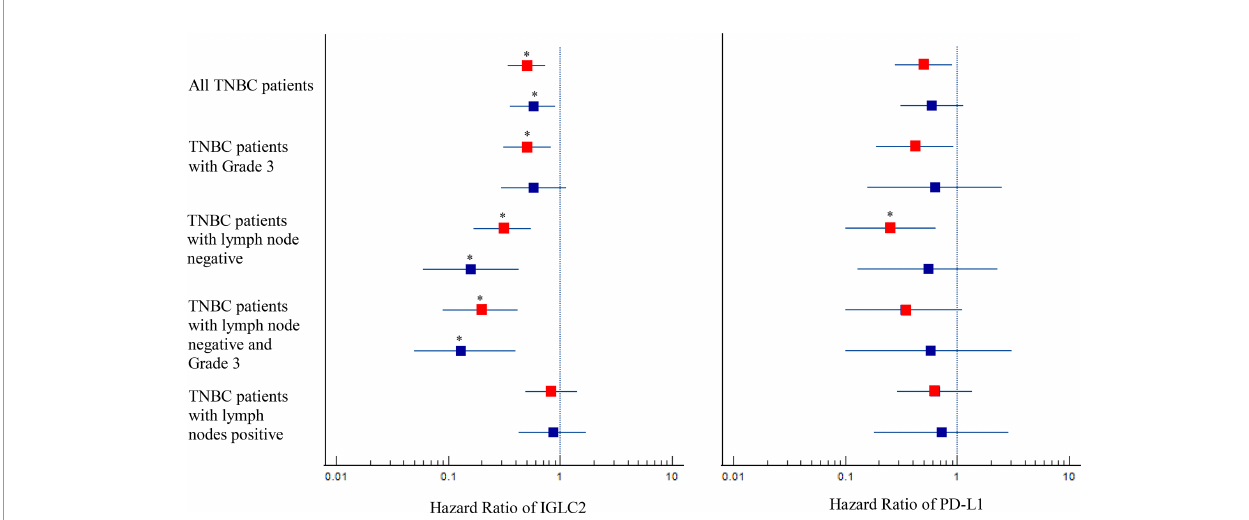
FIGURE 2 | Forest plot with hazard ratio (HR) for IGLC2 and PD-L1 of Kaplan – Meier (KM) survival analysis of RFS and DMFS. The HRs were obtained from the KM plotter online tool. The analysis data were grouped as a whole, by lymph node status, and by Grade 3. The boxplot was the 95% CI of HR. A 95% CI of HR not equal to 1 denotes statistical signi fi cance before multiple comparison adjustment. The HR results of RFS were marked in red, and those of DMFS were marked in blue. The correction of multiple comparisons was using Benjamini-Hochberg method and q values less than 0.05 were marked with an asterisk (*).